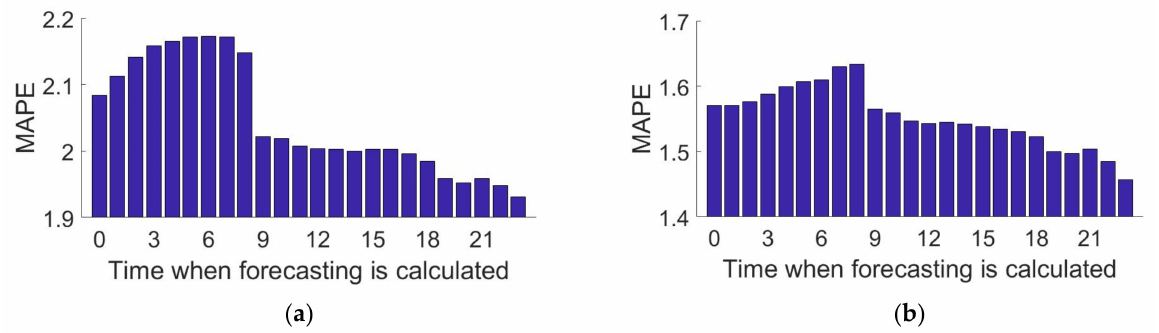
Figure 4. MAPE of every forecast moment during previous days. ( a ) Forecasting load consumed at